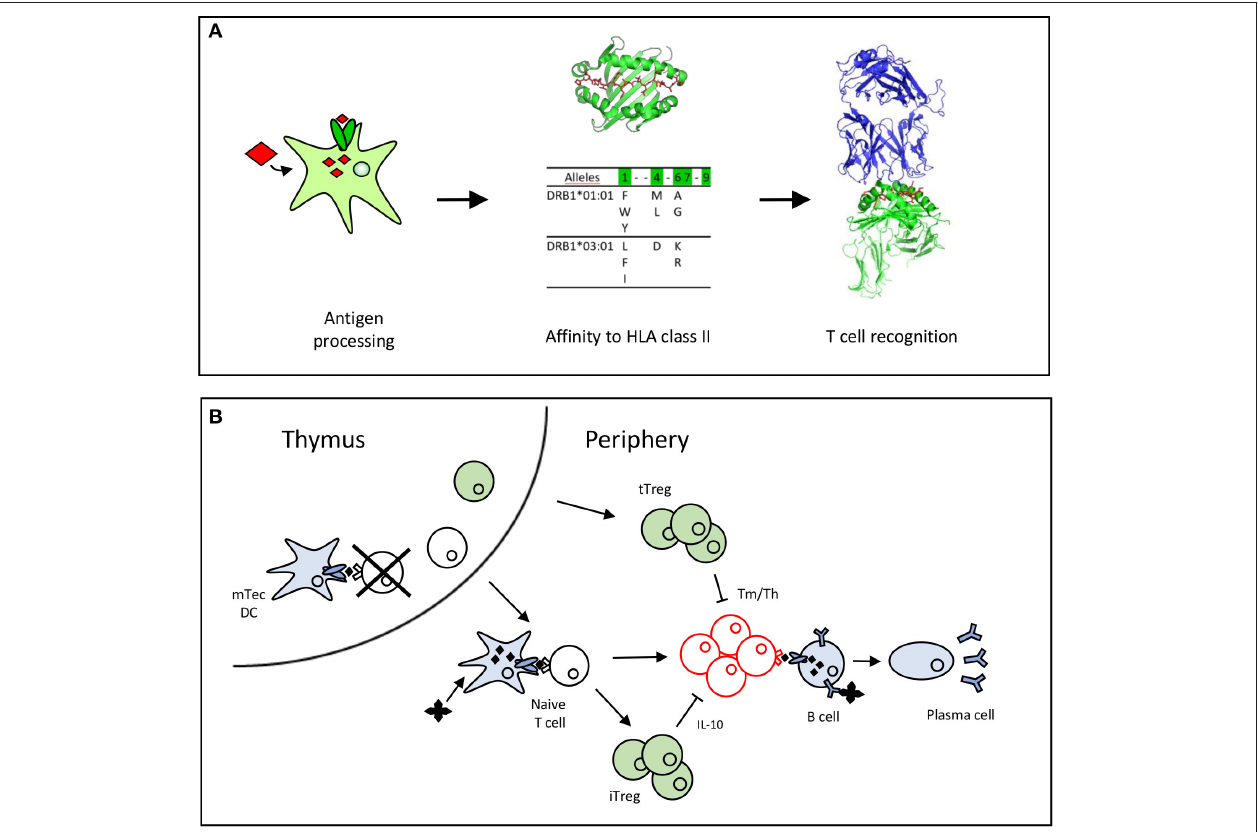
FIGURE 1 | Antigen recognition by T cells leads to T cell selection and expansion. (A) Peptide requirements for T cell recognition (19). A T cell epitope is processed by the dendritic cell, binds to HLA class II molecules (16, 20) and is recognized by the TCR (21). (B) T cells are selected positively and negatively by recognition of self-peptides in the thymus. In the periphery, the naïve T cells recognize antigenic peptides to expand and differentiate into memory or effector T cells (Tm/Teff). Thymic T cells (tTregs) are committed in the thymus to regulatory T cells, while induced regulatory T cells (iTreg), that secrete IL-10 are differentiated from the pool of naïve cells in the